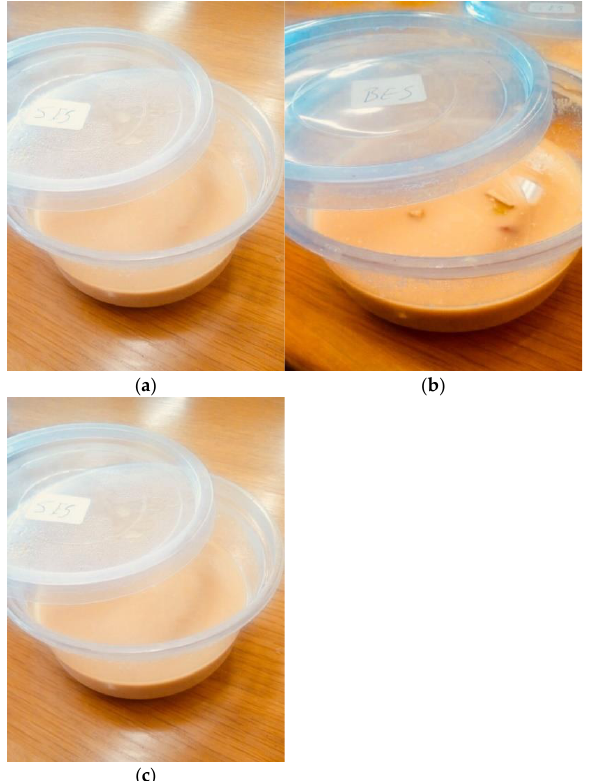
Figure 8. Instant egusi soup made from ( a ) boiled grits, ( b ) spherified grits and ( c ) extruded grits.